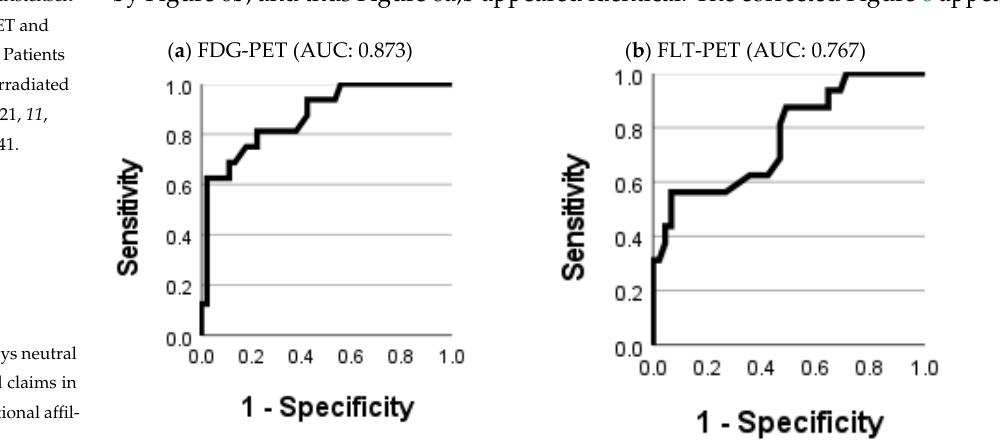
Figure 6. Receiver operating characteristic (ROC) curves for the relapse diagnosis with FDG-SUV max ( a ) and FLT-SUV max ( b ).